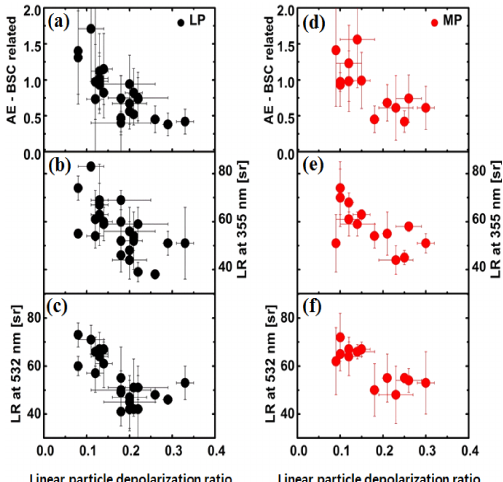
Figure 5. Scatterplot of the linear particle depolarization at 532nm versus (a, d) the backscatter-related Ångström exponent (355/532nm wavelength pair), (b, e) the lidar ratio at 355nm and (c, f) the lidar ratio at 532nm. The left column (a–c) shows the op- tical properties of Asian dust layers considered less polluted (LP), the right column (d–f) shows the more polluted